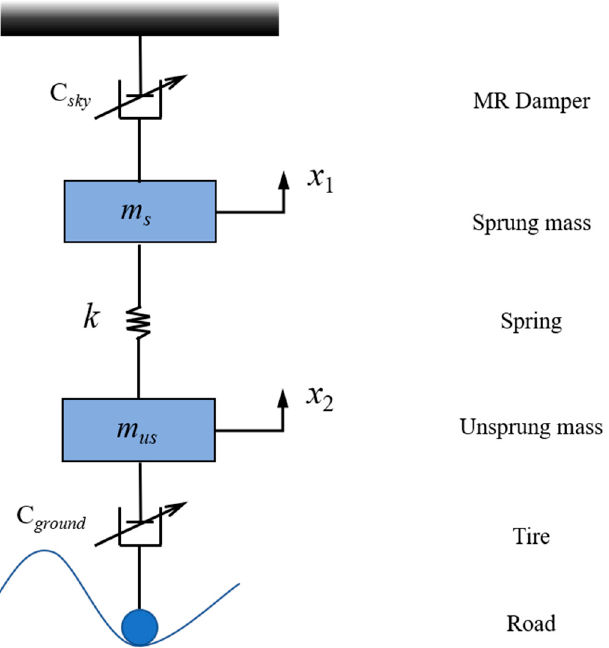
Figure 3. A semi ‐ active system with the sky–groundhook controller [18]. Reproduced with permis ‐ Figure 3. A semi-active system with the sky–groundhook controller [18]. Reproduced with permis- sion from Choi, S. ‐ B. and Han, Y. ‐ M., Magnetorheological Fluid Technology: Applications in Vehi ‐ sion from Choi, S.-B. and Han, Y.-M., Magnetorheological Fluid Technology: Applications in Vehicle cle Systems; published by CRC Press, 2013. Systems; published by CRC Press,